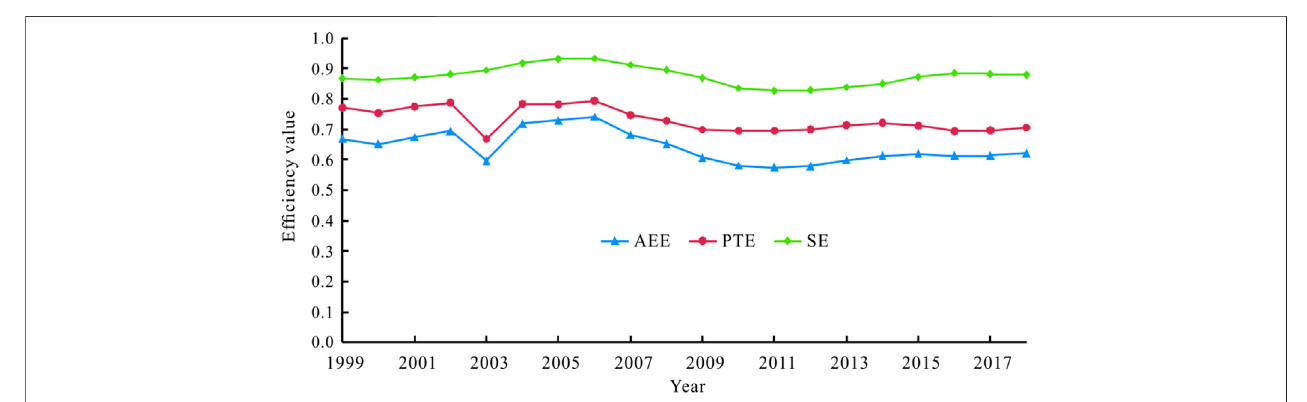
FIGURE 2 | Temporal variation of the AEE, PTE, and SE from 1999 to 2018.